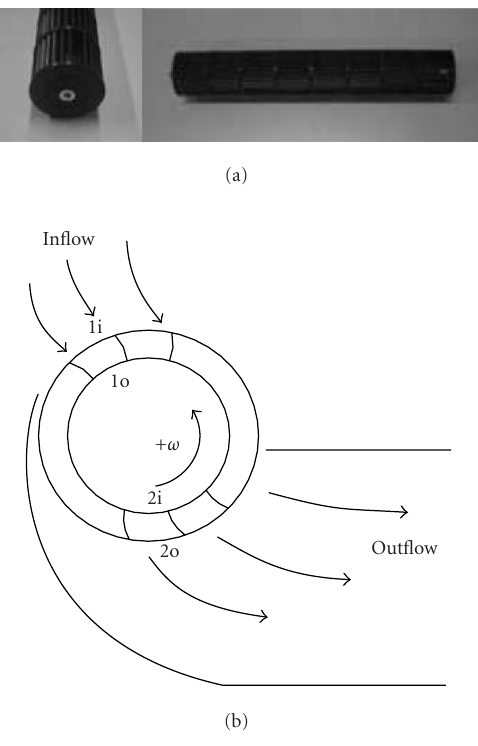
Figure 1: Overall geometry and flow configuration of a cross-flow fan.